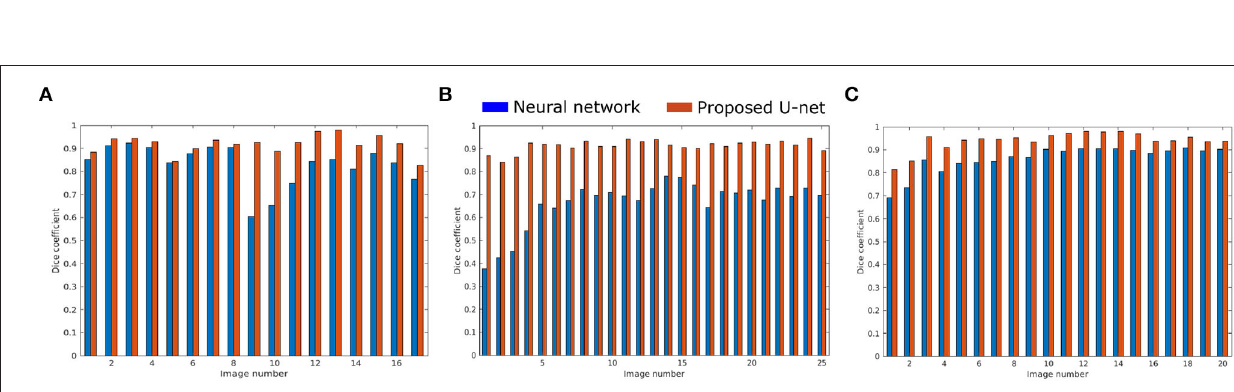
FIGURE 8 | Examples of segmentation of arabidopsis top-view images from Scharr et al. All images were segmented with DC over 0.9.